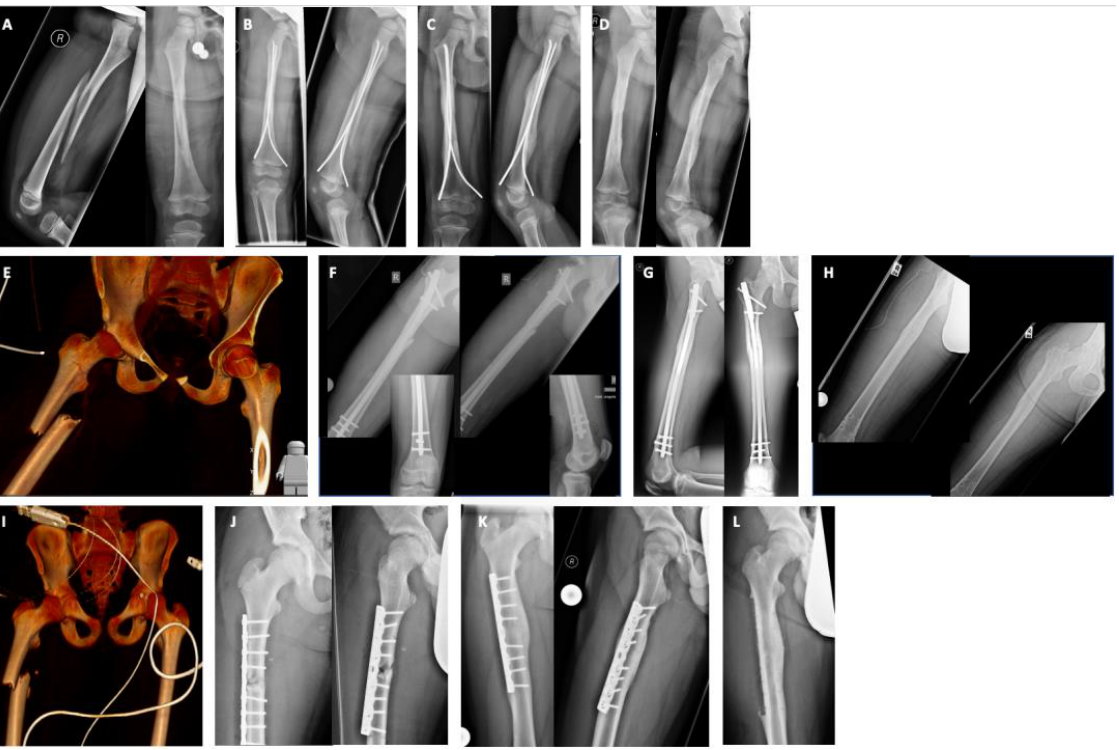
Figure 2. Different treatment strategies in children with femur fracturea. X-ray series demonstrating fracture type, treatment and bone healing process. ( A – D ): One-year-old boy twisted the leg while playing: 32-D/5.1 ( A ), ESIN ( B ) with secondary bone healing ( C ) and after hardware removal ( D ). ( E – H ): Sixteen-year-old boy after traffic accident with collision (moped against car): 32-d/4.1 ( E ), IMN ( F ) with mainly primary bone healing ( G ) and after hardware removal ( H ). ( I – L ): Twelve-year-old boy after traffic accident with collision (bicycle against car): 32-D/4.1 ( I ), ORIF ( J ) with mainly primary bone healing ( K ) and after hardware removal ( L ).